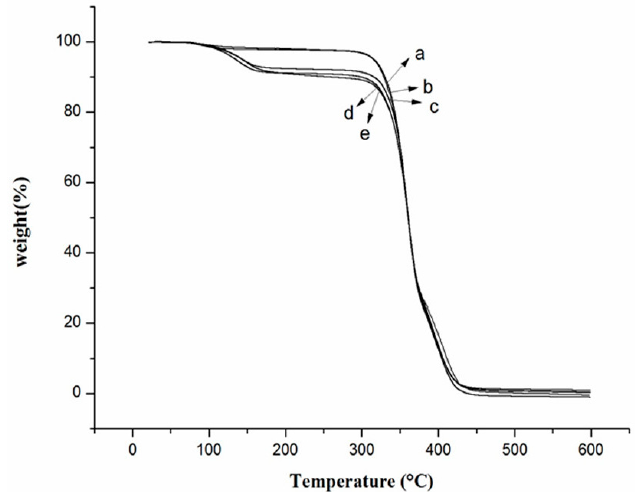
Figure 3. Thermogravimetric analysis curves of poly (lactic acid)/poly (trimethylene carbonate)/oregano essential oil composite films ( a ) PLA/PTMC; ( b ) PLA/PTMC/O3; ( c ) PLA/PTMC/O6; ( d ) PLA/PTMC/O9 and ( e ) PLA/PTMC/O12.